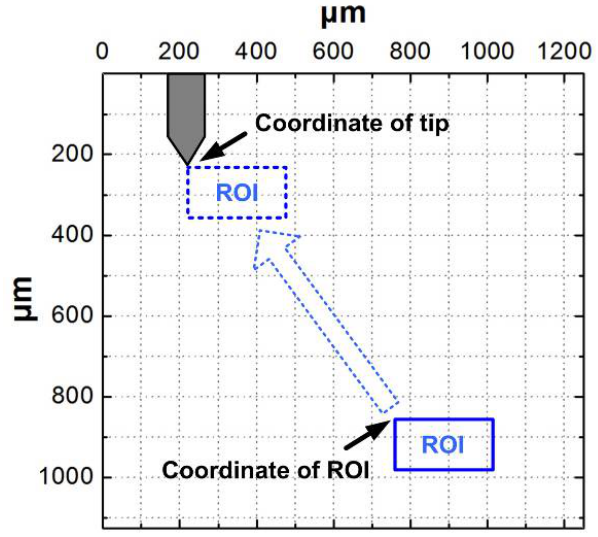
Figure 8. The coordinate unified schematic drawing of the AFM and the white light scanning